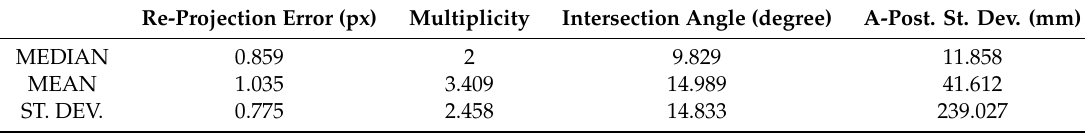
Table 15. Median, mean and standard deviation values for the quality parameter values computed on the original (not filtered) sparse point cloud (~315,000 3D tie points). Table 16. Values of the quality parameters computed on the filtered sparse point cloud and average variation of the results.